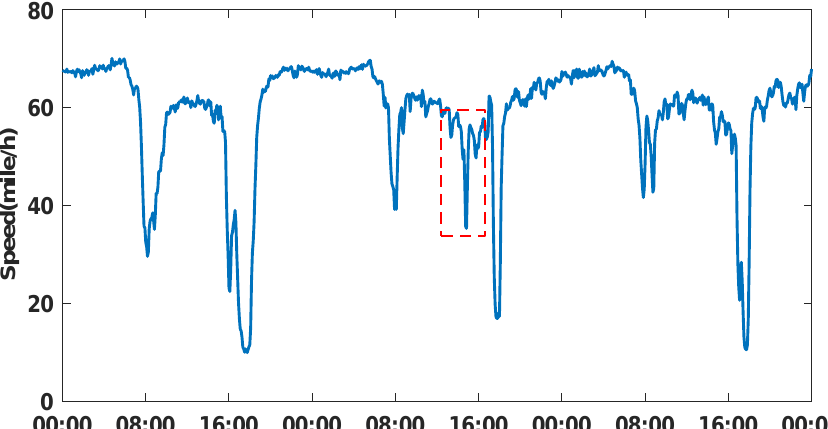
Figure 1. Traffic speed of a traffic node on three consecutive days. The value of speed follows a similar periodic trend on these days, but may see anomalous fluctuation in the short period indicated by the red dotted box.